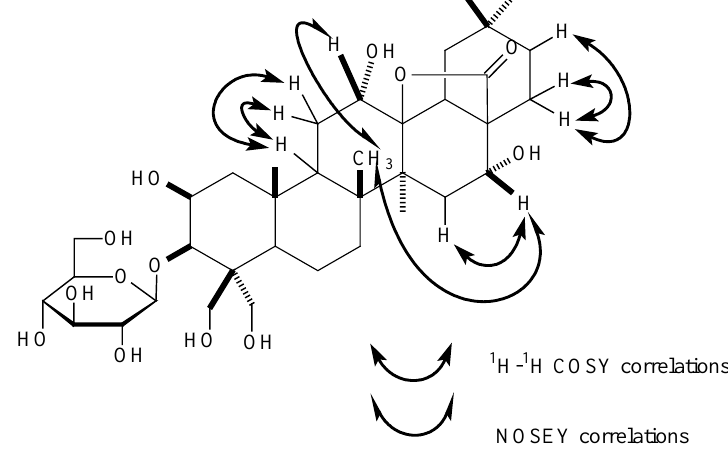
Figure 2 . Key correlations in the 1 H- 1 H COSY and NOESY spectra of 1